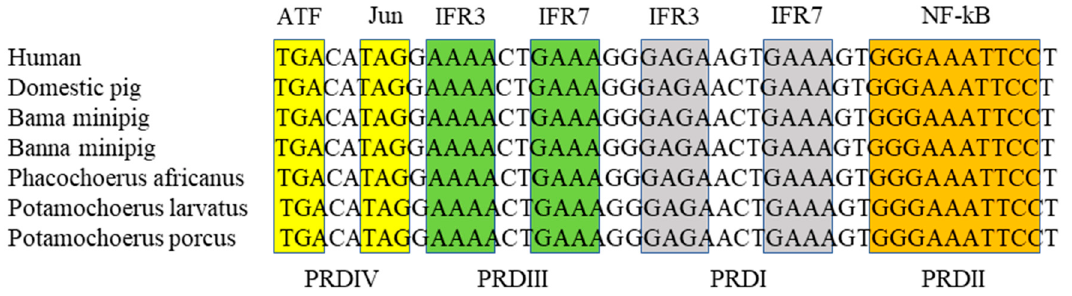
Figure 3. Sequence alignment of the promoter domains in PoIFN ‐β of different pig species. The promoter domains (PRDs) in PoIFN ‐β of two Chinese miniature pig breeds were identical with that of humans, domestic pigs, and African wild